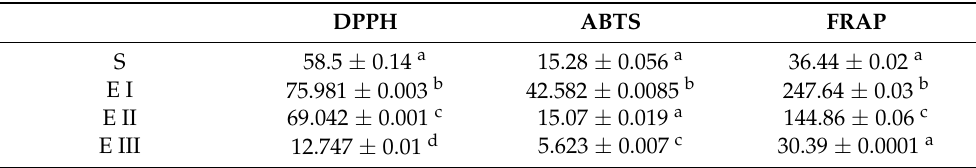
Table 2. Antioxidant capacity (ABTS, DPPH inhibition %, and reduction capacity–FRAP) during the different stages of the